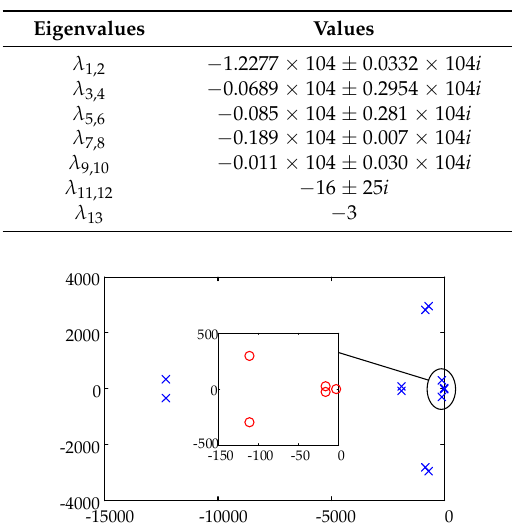
Figure A1. Eigenvalue diagram of IIDG detailed model, where the red circle indicates the dominant low-frequency eigenvalues.